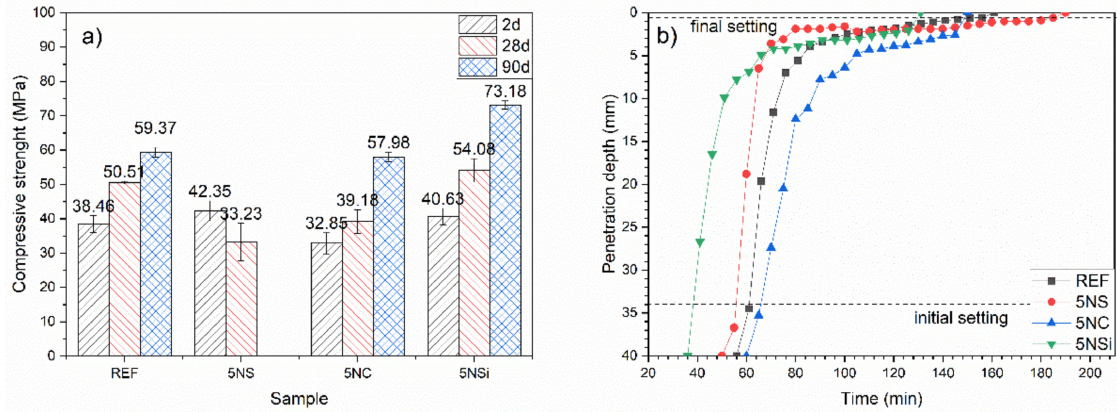
Figure 2. ( a ) Compressive strength and ( b ) setting times for 2-, 28-, and 90-d